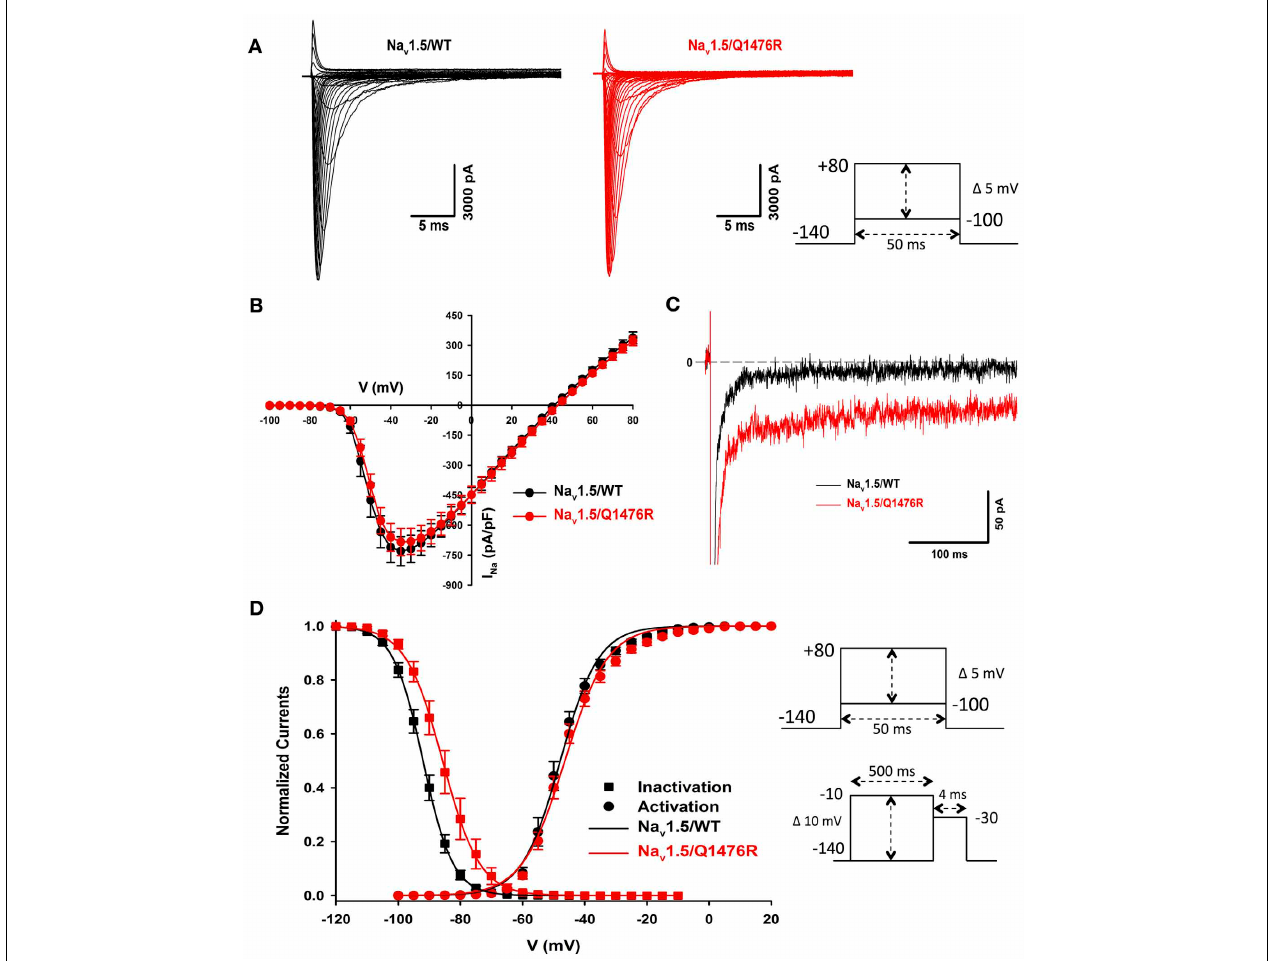
in red. (D) Voltage dependence of SS activation (circles) or inactivation (squares) for the WT (black) and Q1476R (red) Na v 1.5 Na v 1.5 channels. A standard Boltzmann function was used to fit activation curves and to obtain the V 1 / 2 and given in Table 1 [ G ( V )/ G max = 1 /( 1 + exp ( − ( V − V 1 / 2 )/ k )) ]. Inactivation currents were obtained by applying conditioning pre-pulses to membrane potentials ranging from a holding potential of − 140 to − 10mV for 500ms in 5mV increments and were then measured using a 4-ms pulse to − 30mV at each step (see protocol in inset). The recorded inactivation values were fitted to a standard Boltzmann